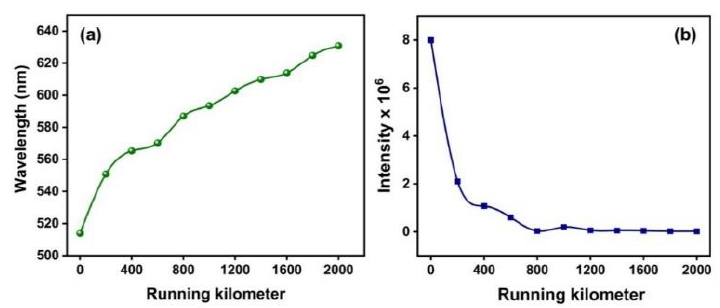
Figure 6. ( a ) Emission peak shift and ( b ) emission peak intensity variation with running kilometres for 442 nm excitation.